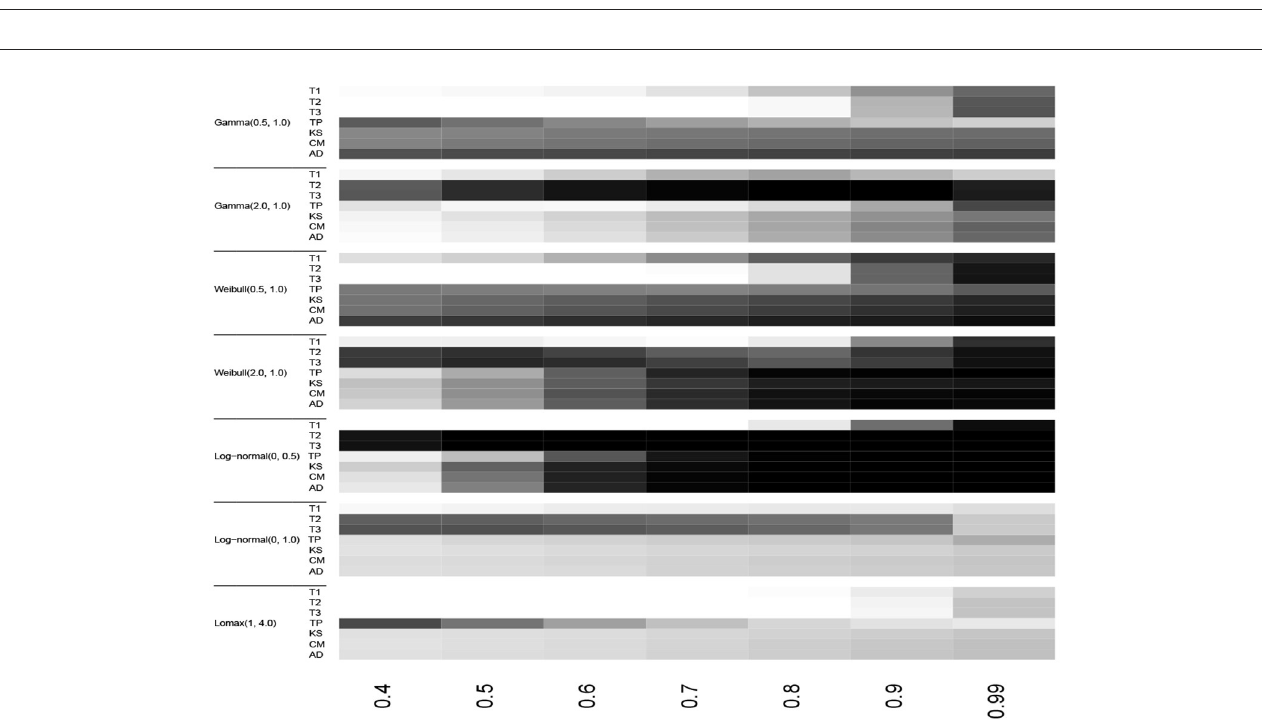
10, α 0.10 and 10 5 iterations. = =